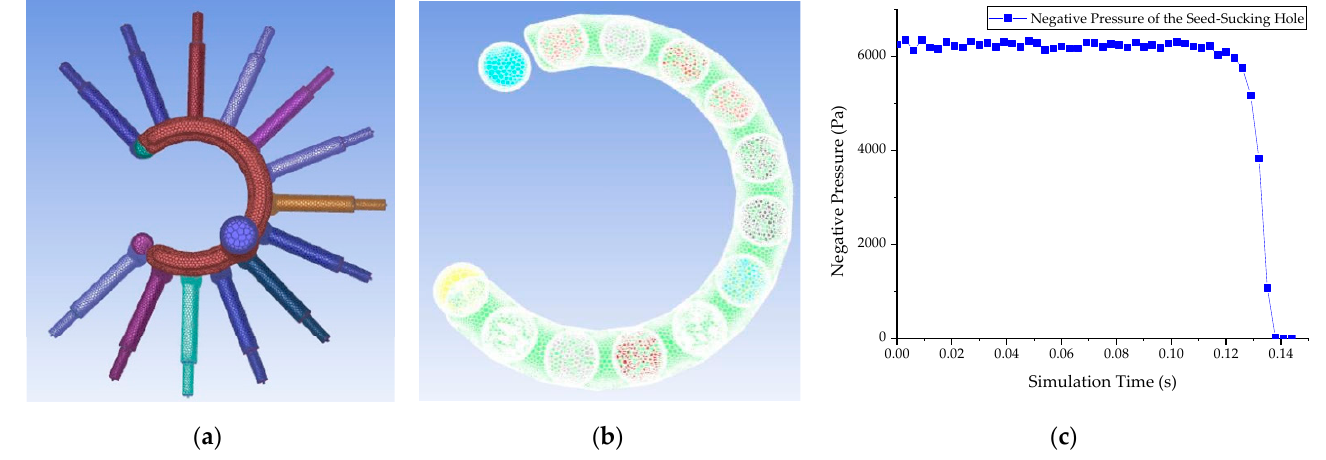
Figure 10. Diagram of simulation process and results: ( a ) fluid domain flow diagram; ( b ) interface setting; ( c ) dot–line graph of experiment results.